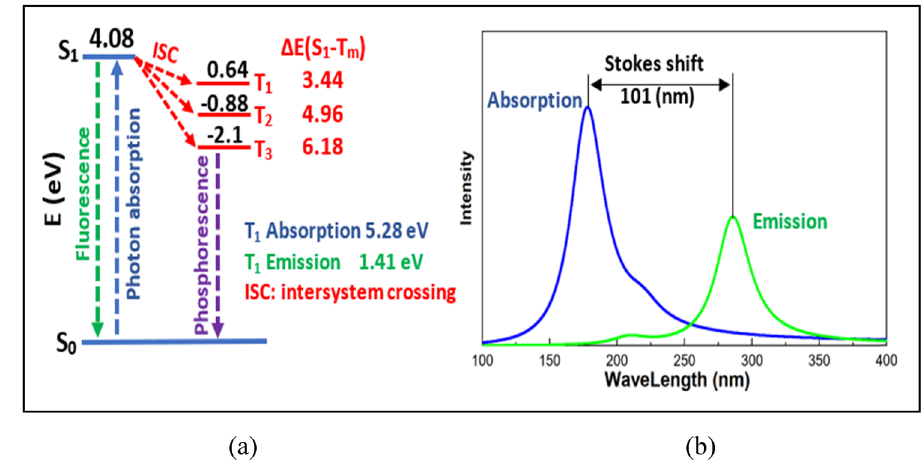
Figure 7: ( a ) The Jablonski energy diagram. ( b ) Ensemble excitation and emission spectra of nylon